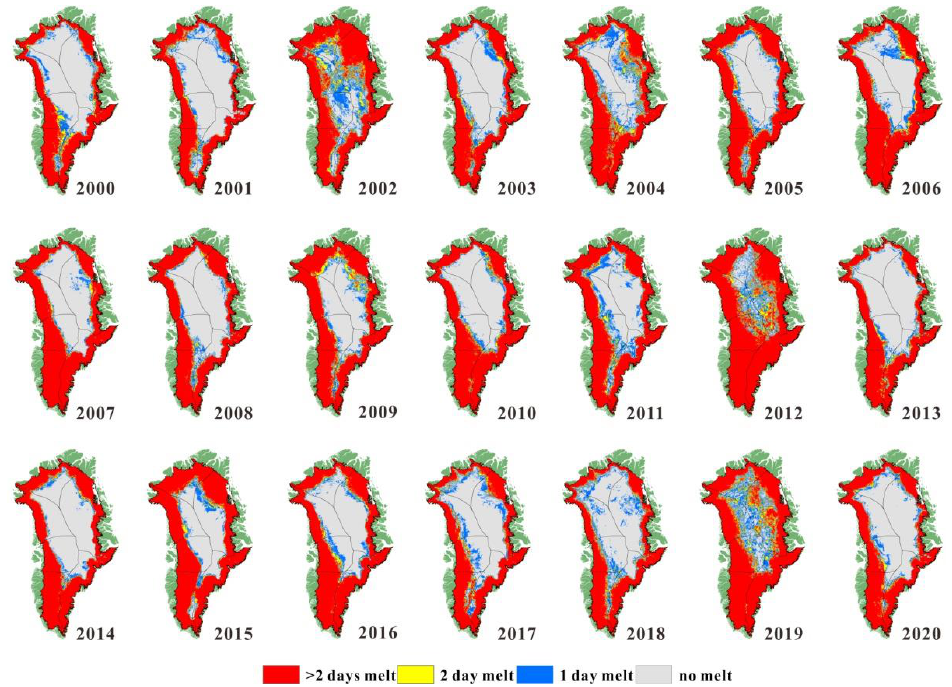
Figure 6. The GrIS cumulative melting extent for summer from 2000 to 2020.